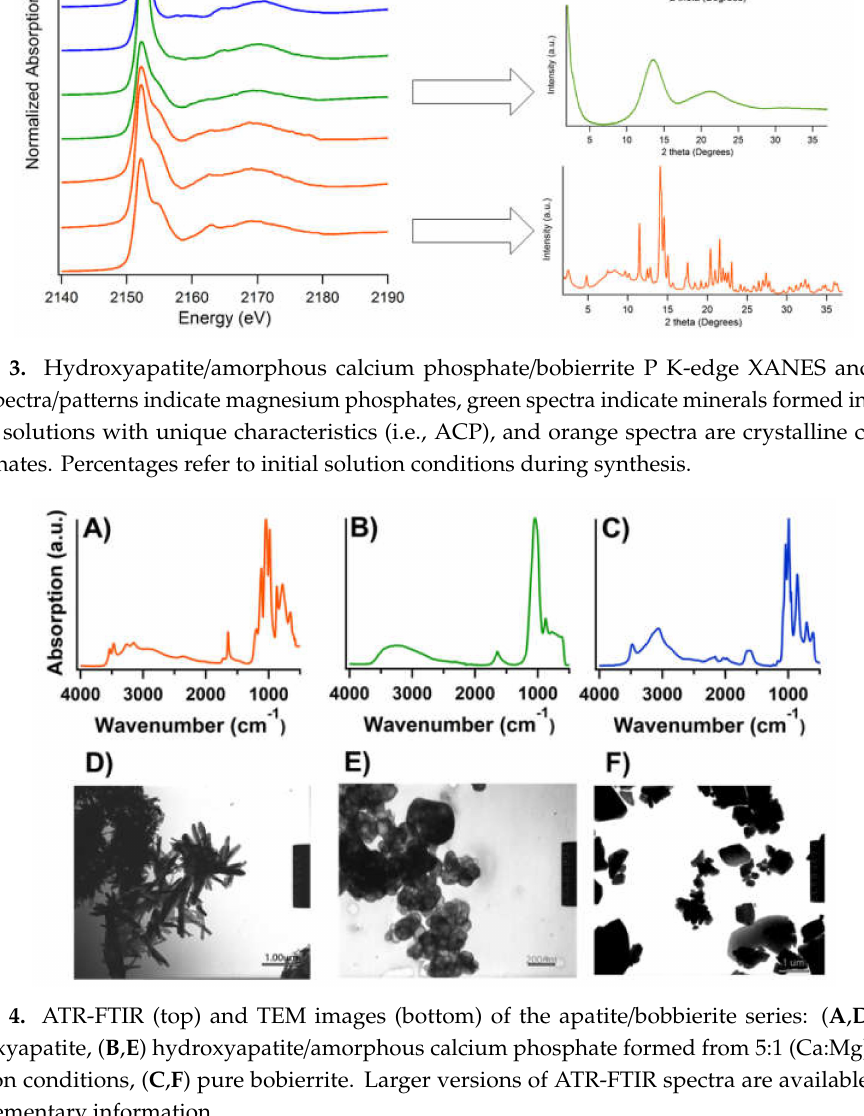
(Table 1) The Ca:P ratio of these minerals falls within the range of what is considered ACP: 1.41 in the 5:1 mineral to 1.34 in 1:1 mineral [1]. There is no corresponding increase in Mg content that would indicate significant cationic substitution; the 5:1 ratio synthesized mineral is only 6.0% Mg in the solid-state. The XRD patterns of these phases are amorphous, with no defined peaks and